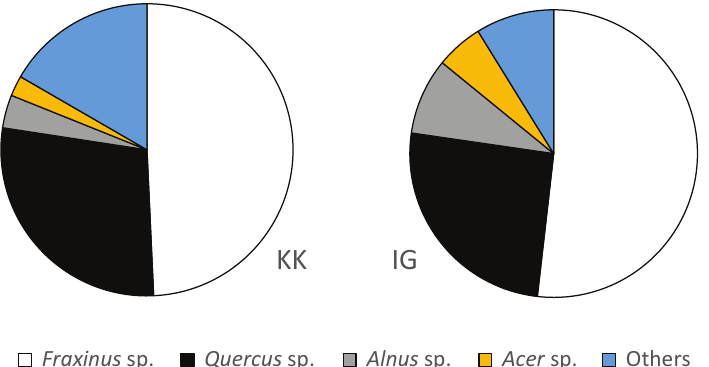
Figure 3. The relative abundance of the dominant taxa in the post assemblages per site cluster. ( a ) cluster Kamnik pod Krimom (KK), based on ten sites, n = 3578 posts, ( b ) cluster Ig, based on five sites, n = 2780 posts. Others = Abies sp., Corylus sp., Carpinus sp., Fagus sp., Populus sp., Salix sp., Ulmus sp., and a few samples that were not identified due to poor preservation.